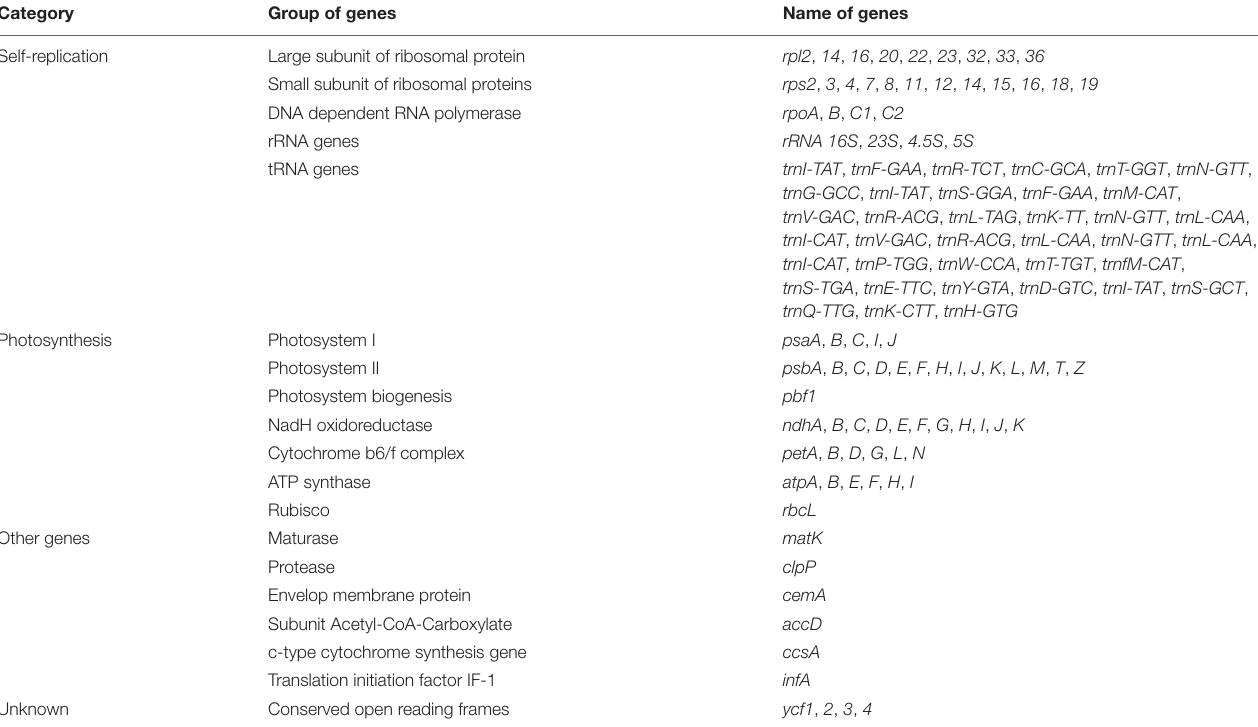
TABLE 1 | List of genes present in the Ulmus laevis chloroplast genome. Category